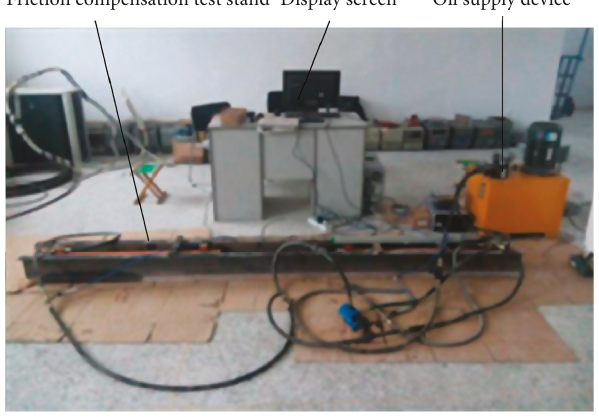
Figure 15: Friction test rig.